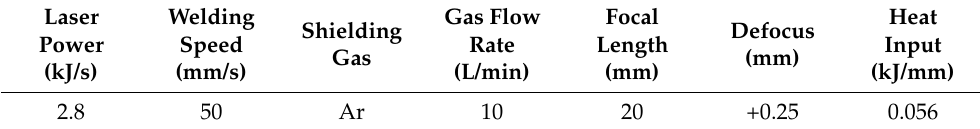
Table 4. Process parameters.